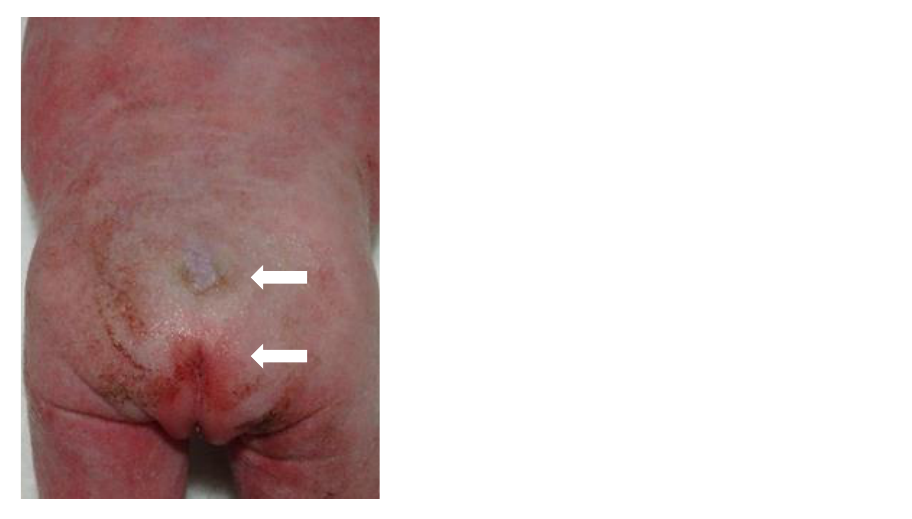
Figure 7. Postmortem sacral dimple (upper arrow) and opening of a sinus (lower arrow).